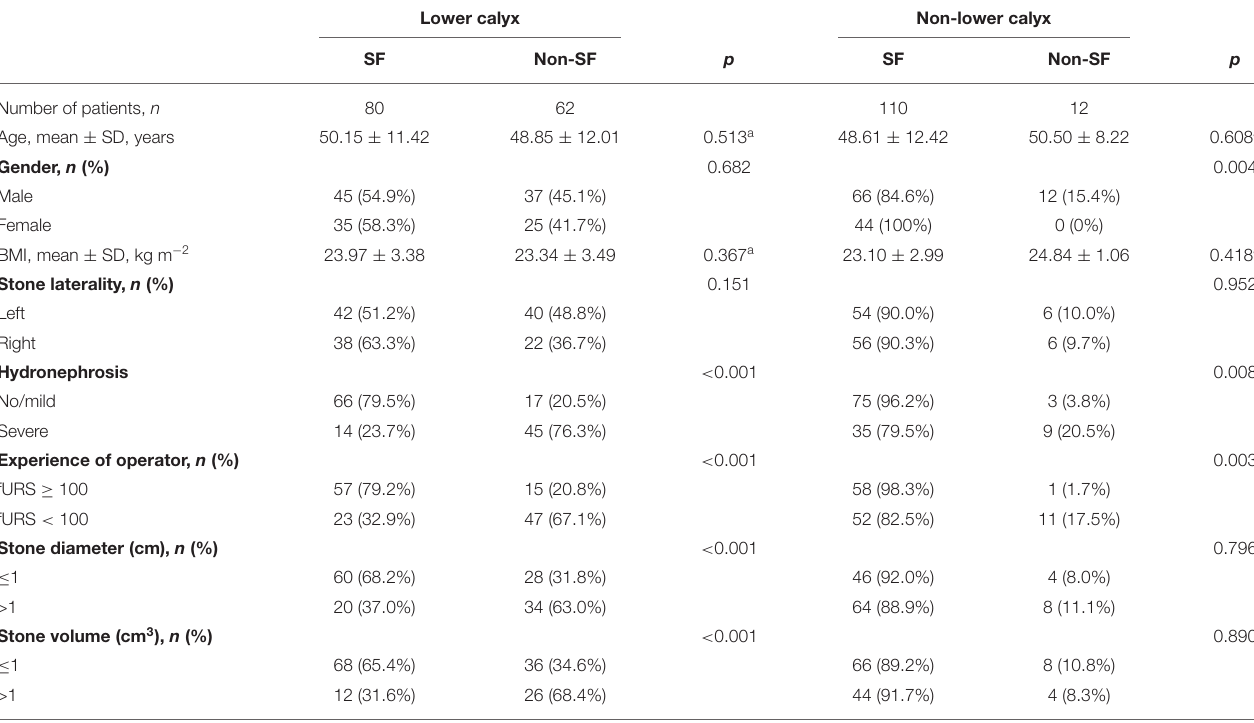
TABLE 2 | Influencing factors on the success rate after fURS between lower calyx stone and non-lower calyx stone patients. Lower calyx Non-lower calyx SF